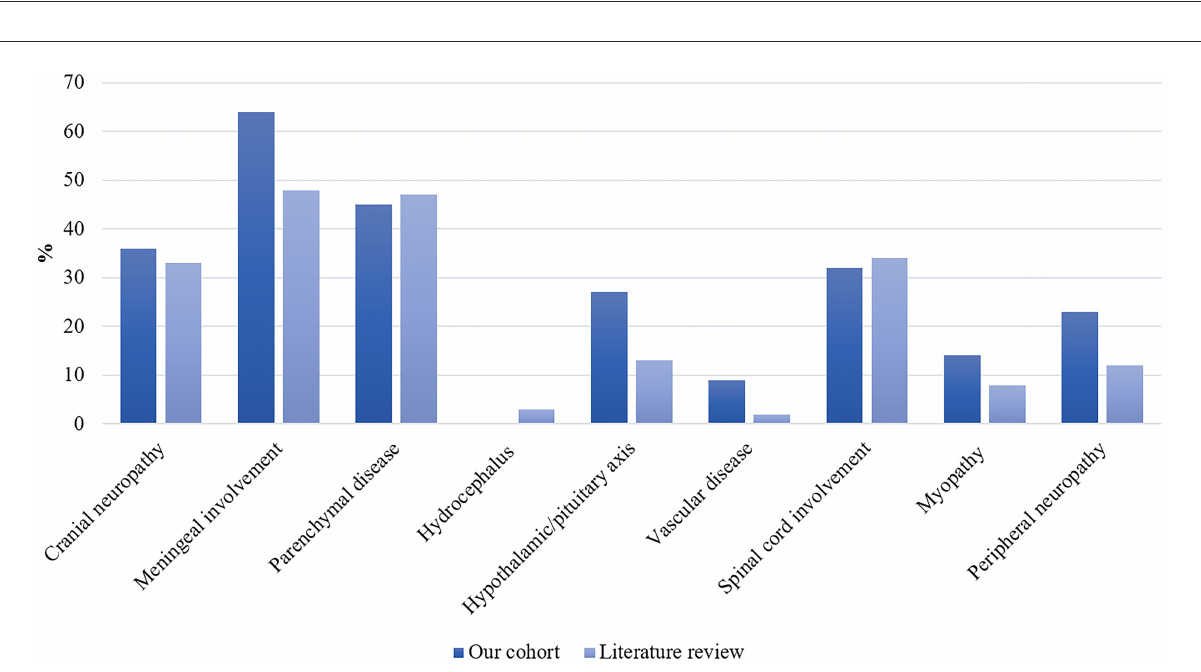
FIGURE3 Distribution of neurological site involvement of neurosarcoidosis in our patient cohort ( n = 22) and the literature as expressed as percentages. In the literature: n/N = 498/1,518 for cranial neuropathy; n/N = 722/1,507 for meningeal involvement; n/N = 622/1,334 for parenchymal disease; n/N = 40/1,237 for hydrocephalus; n/N = 162/1,237 for hypothalamic/pituitary axis; n/N = 24/1,237 for vascular disease; n/N = 426/1,237 for spinal cord involvement; n/N = 94/1,237 for myopathy; and n/N = 159/1,353 for peripheral neuropathy.